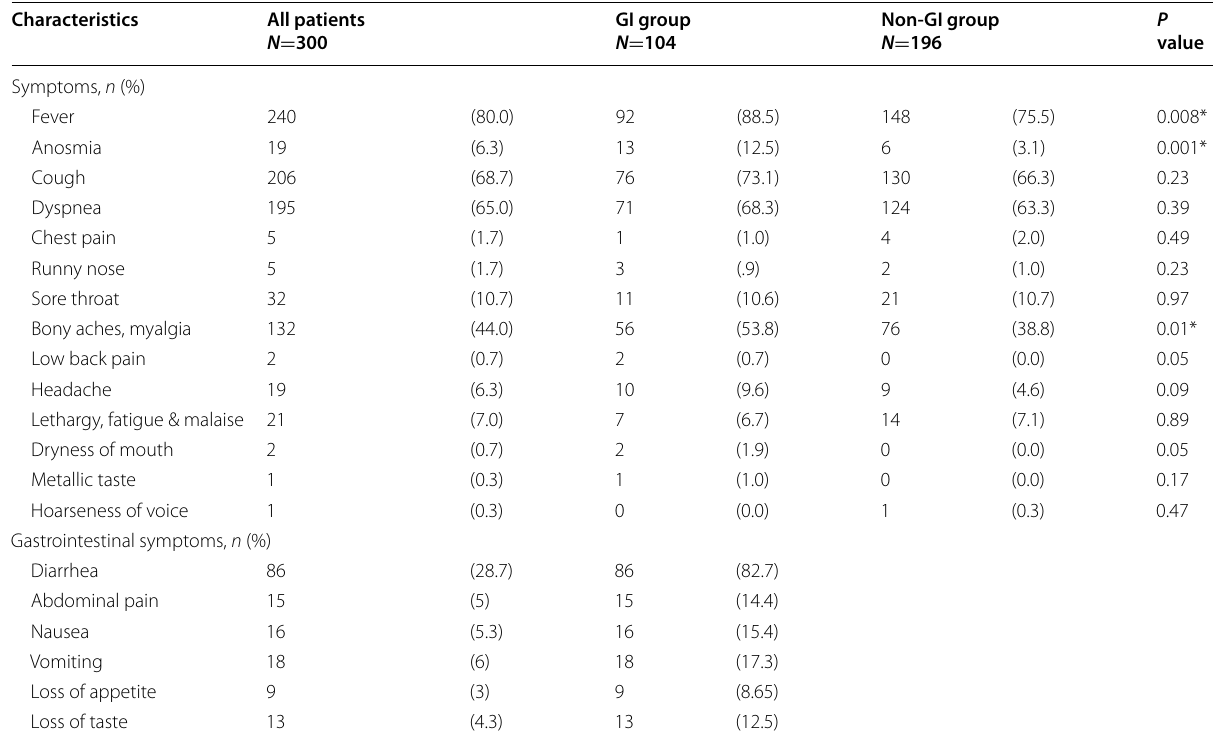
Table 3 Clinical characteristics of patients with